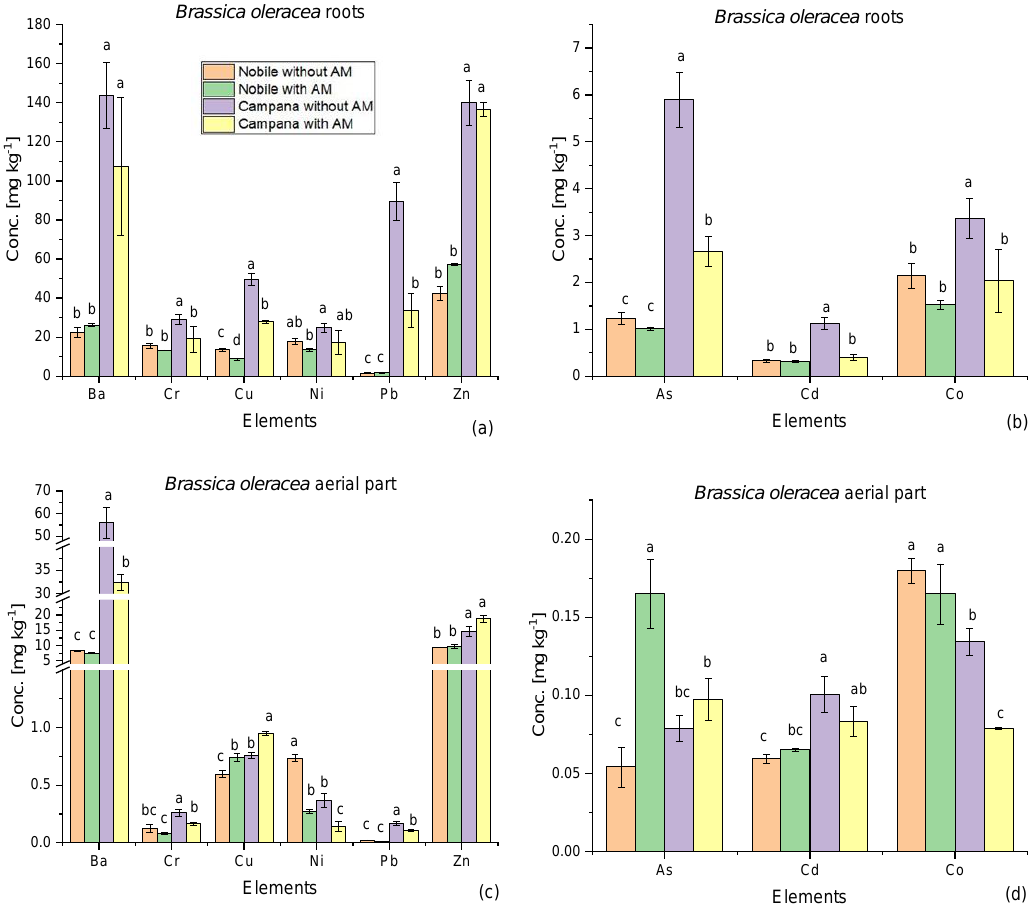
Figure 3. Comparison of potentially toxic elements’ uptake in the roots ( a , b ) and in the aerial part ( c , d ) of Brassica oleracea grown in CA and NOB soils. Element concentrations are expressed as mg kg − 1 dry weight. The letters above columns refer to the summary of multiple comparisons for pairs obtained with Tukey test. Letter b identifies plant samples whose mean concentrations in the respective elements are significantly lower than the ones obtained for plant samples identified by letter a ; the same concept applies to letter c with respect to letter b and letter d with respect to letter c